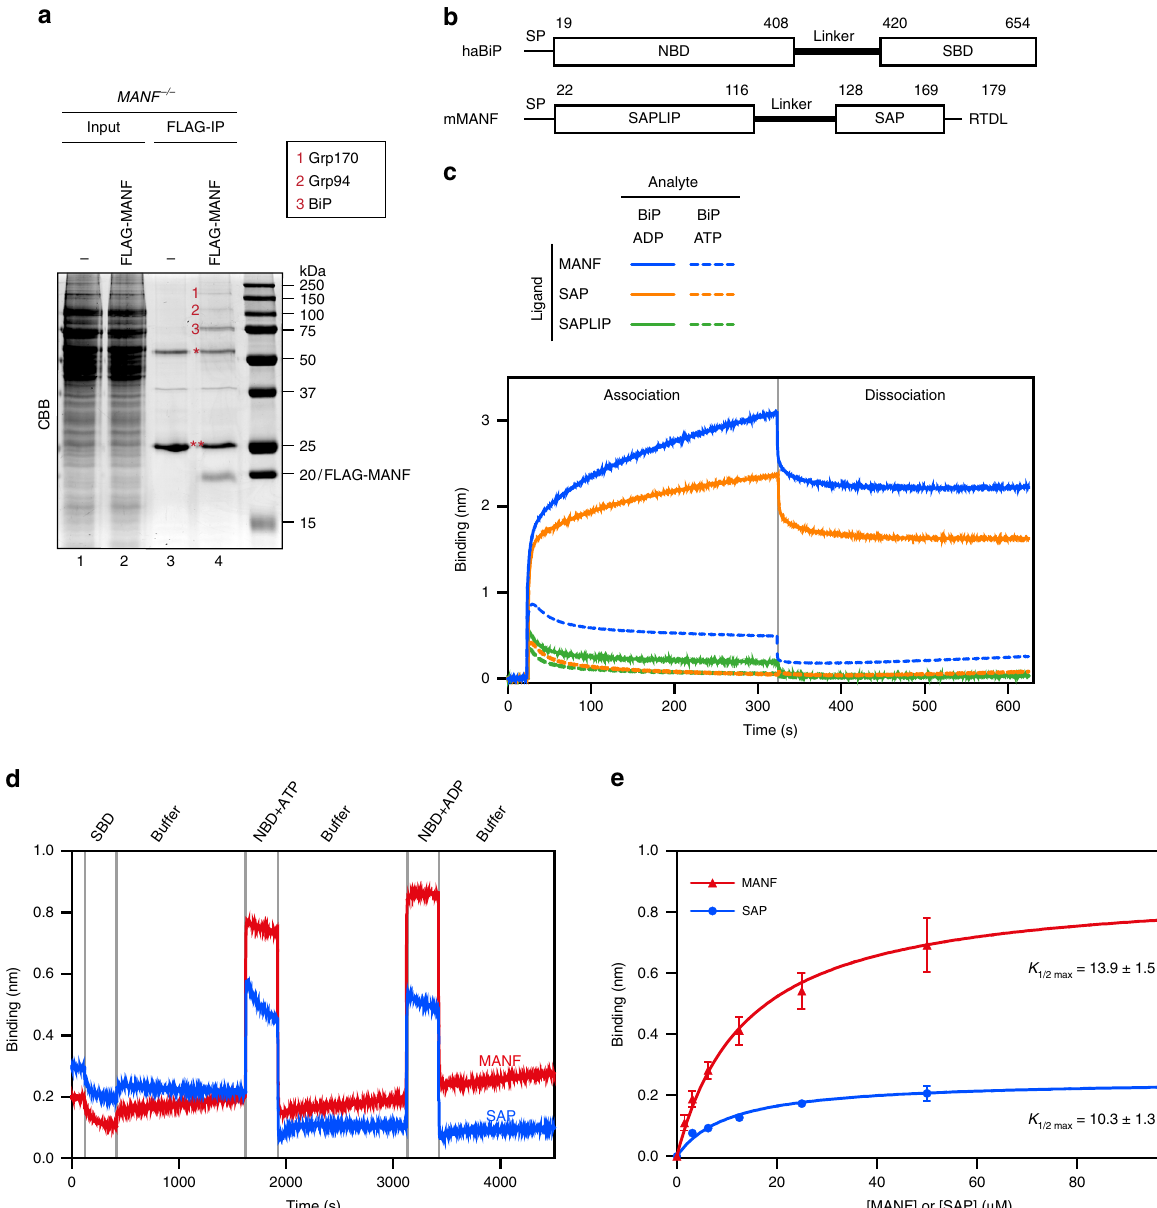
Fig. 2 MANF associates with the ER chaperone BiP in vivo and in vitro. a Coomassie-stained (CBB) SDS-PAGE gel of lysates (Input) and FLAG-M1- immunoaf fi nity puri fi ed proteins (FLAG-IP) from parental CHO-K1 S21 MANF -/- cells and cells stably expressing FLAG-M1-MANF. Indicated bands (1 – 3) of proteins recovered in complex with FLAG-M1-MANF were individually excised and analyzed by mass spectrometry. The heavy (one asterisk) and light (two asterisks) chains from the ANTI-FLAG M1 agarose af fi nity gel are indicated. Data representative of two independent experiments are shown. Note that BiP (72 kDa) was unambiguously identi fi ed in band 3. b Schema of the domain structure of Chinese hamster BiP (haBiP) and mouse MANF (mMANF).